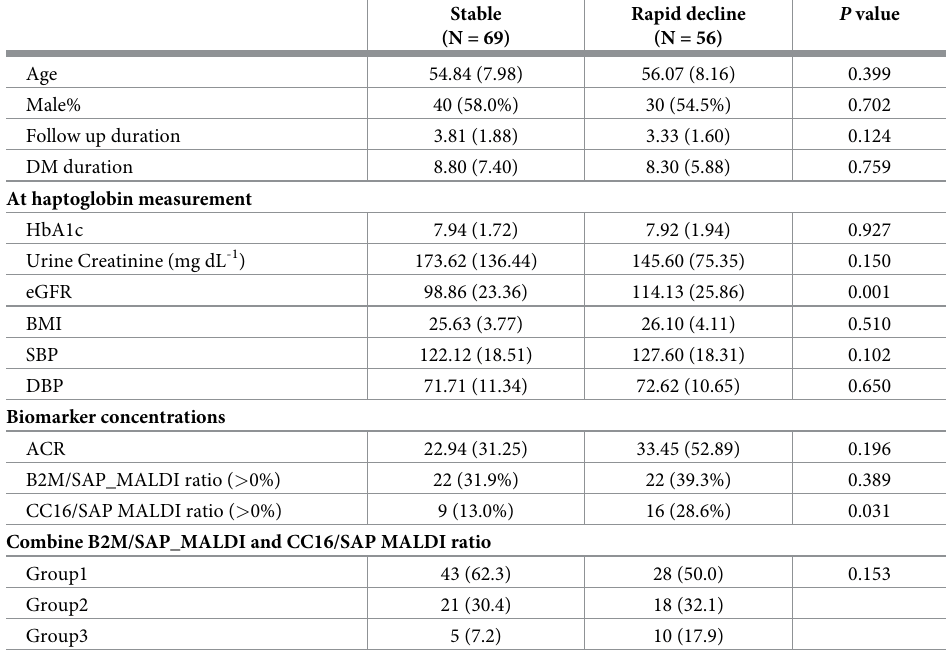
Table 2. Demographic and clinical characteristics stratified by decline in eGFR/year ≧ 3.3%